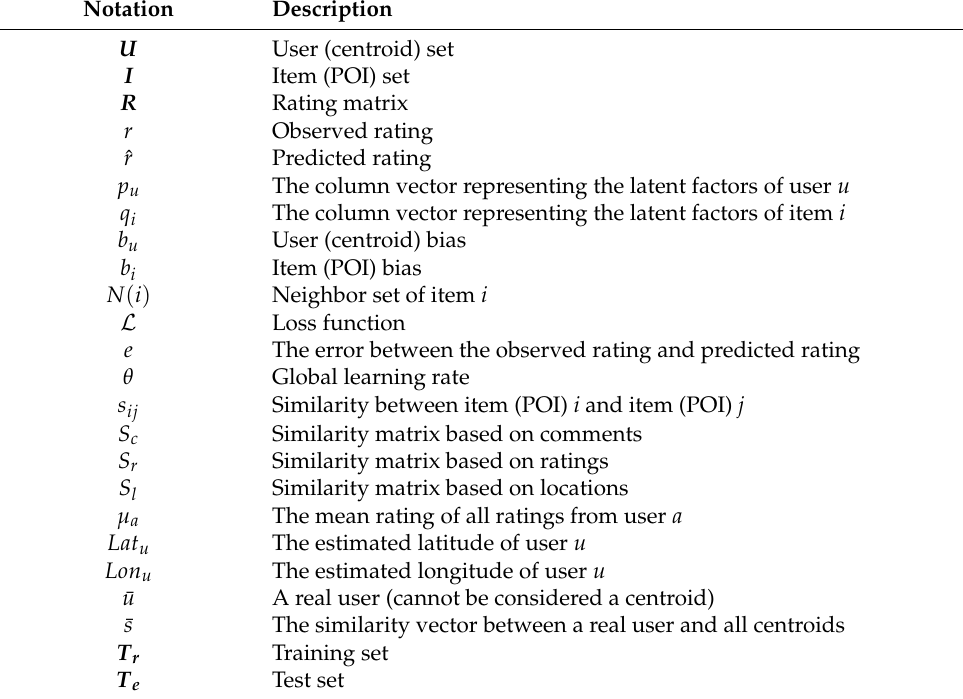
Table 1. Notation